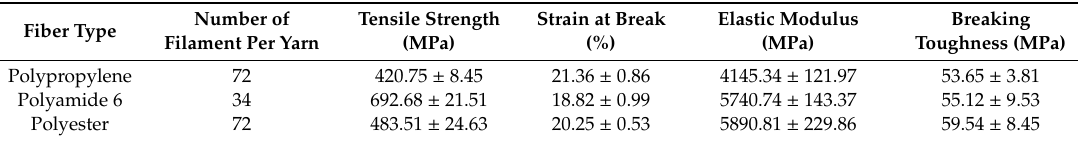
Table 1. Characteristic of yarns used for experiments.